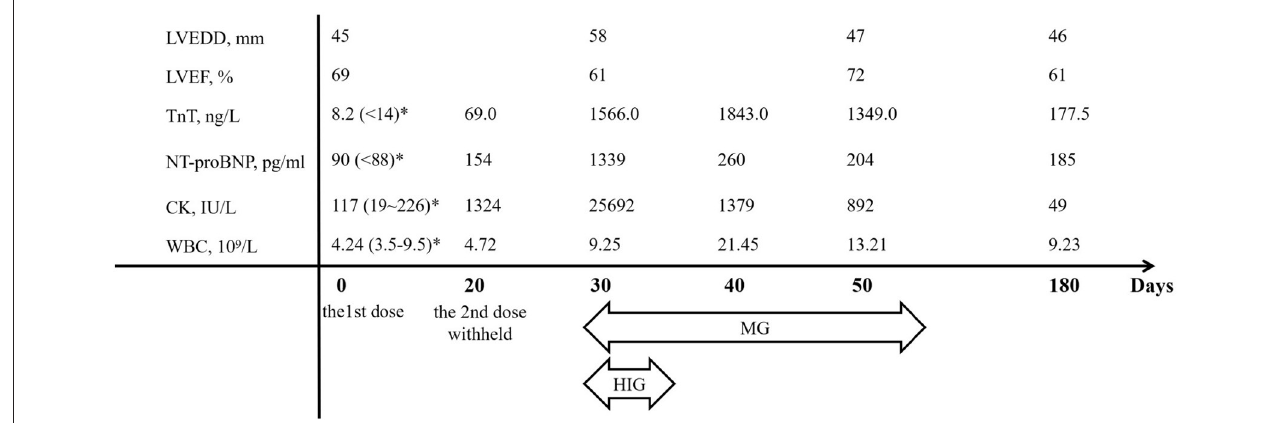
FIGURE 2 | The chronological changes of major parameters. CK, creatine kinase; HIG, human immunoglobulin; LVEDD, left ventricular end-diastolic dimension; LVEF, left ventricular ejection fraction; MG, methylprednisolone; NT-proBNP, N-terminal pro-brain natriuretic peptide; TnT, troponin-T; WBC, white blood cell count. *Normal ranges in